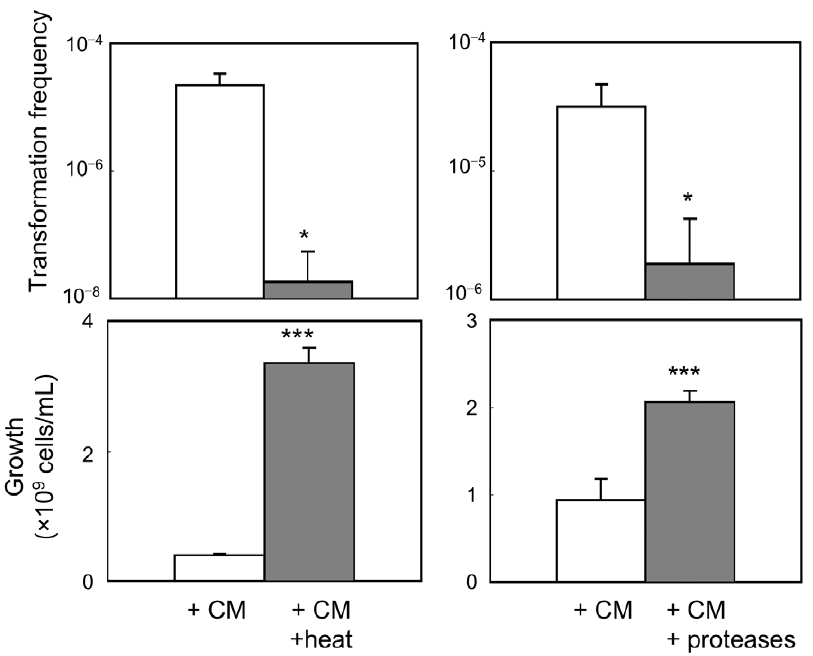
Figure 4. Characterization of putative active factor in CM of CAG18439. Effects of heat exposure and protease treatment of CM of CAG18439 on cell-to-cell transformation and cell growth in co-culture of MG1655 harbouring pHSG299 and MC4100. Heat treatment of CM was performed at 121 u C for 20 min. Treatment of CM with trypsin (100 m g/mL) and proteinase K (200 m g/mL) was performed at 37 u C for 120 min. CM was used for culture at 50% (v/v) in heat experiments and at 1% (v/v) in protease experiments. Data are presented as mean and S.D. (*: t -test: P , 0.05, n =4; { : t -test: P , 0.005, n =4).